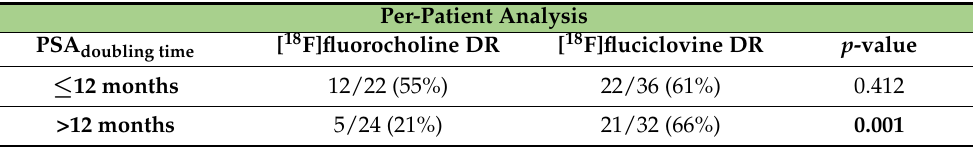
Figure 2. ROC analysis identified the optimal PSA cut-off value of ( a ) 0.94 ng/mL for the [ 18 F]fluorocholine PET/CT and of ( b ) 0.45 ng/mL for the [ 18 F]fluciclovine PET/CT. PSAdt did not show a statistically significant impact on the per-patient [ 18 F]fluciclovine PET/CT DR. Conversely, PSAdt impacted the [ 18 F]fluorocholine PET/CT DR, namely a significantly higher number of positive scans was observed in patients with a faster PSAdt (PSAdt ≤ 12 months: 55%, 12/22; PSAdt > 12 months: 21%; p = 0.018). For PSAdt, the comparison between the two radiopharmaceuticals groups showed a statistically significant higher overall DR in the [ 18 F]fluciclovine group for a slower PSAdt value ( p = 0.001). All per-patient DR results are reported in Table 3. Per-patient detection rate (DR) analysis comparing the [ 18 F]fluorocholine and [ 18 F]fluciclovine groups stratified according to Prostate-Specific Antigen doubling time (PSAdt)